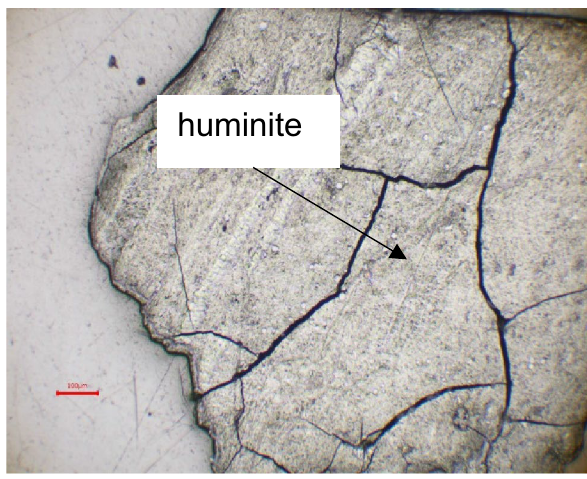
Fig. 13 Huminite on coal sample on image under white